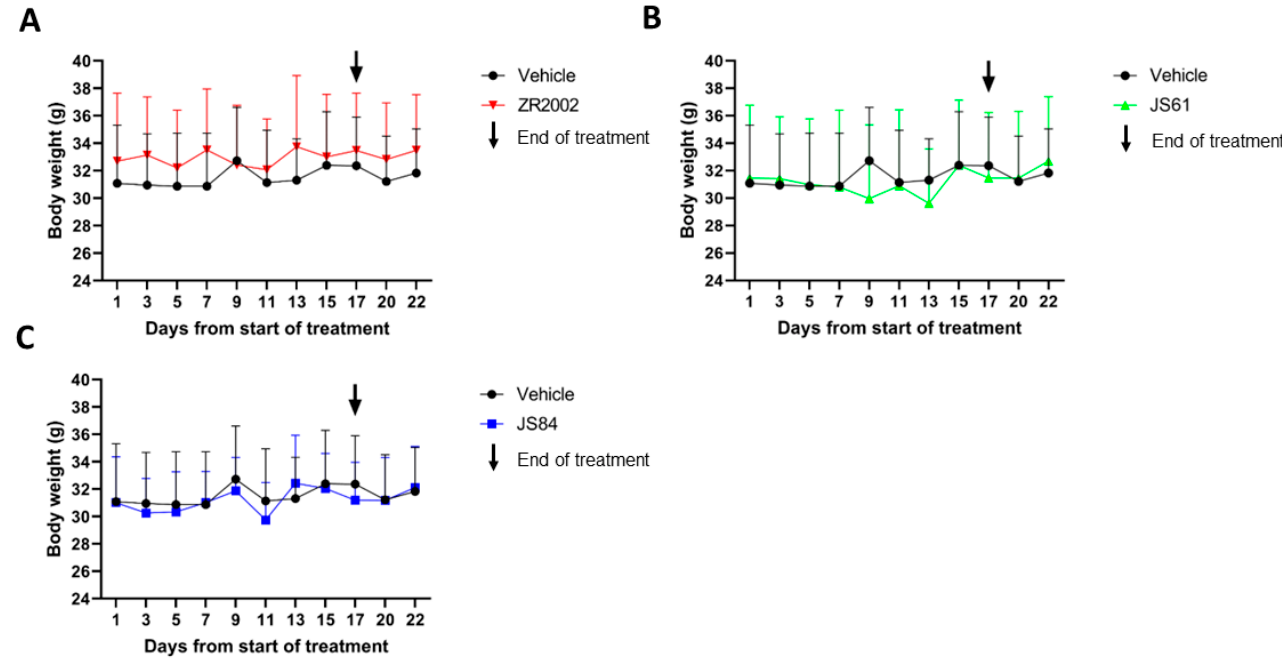
Figure A2. Body weights of mice treated (N = 7) with the combi-molecules. ( A ) ZR2002 versus vehicle. ( B ) JS61 versus vehicle. ( C ) JS84 versus vehicle. Data are expressed as means ± SEM.